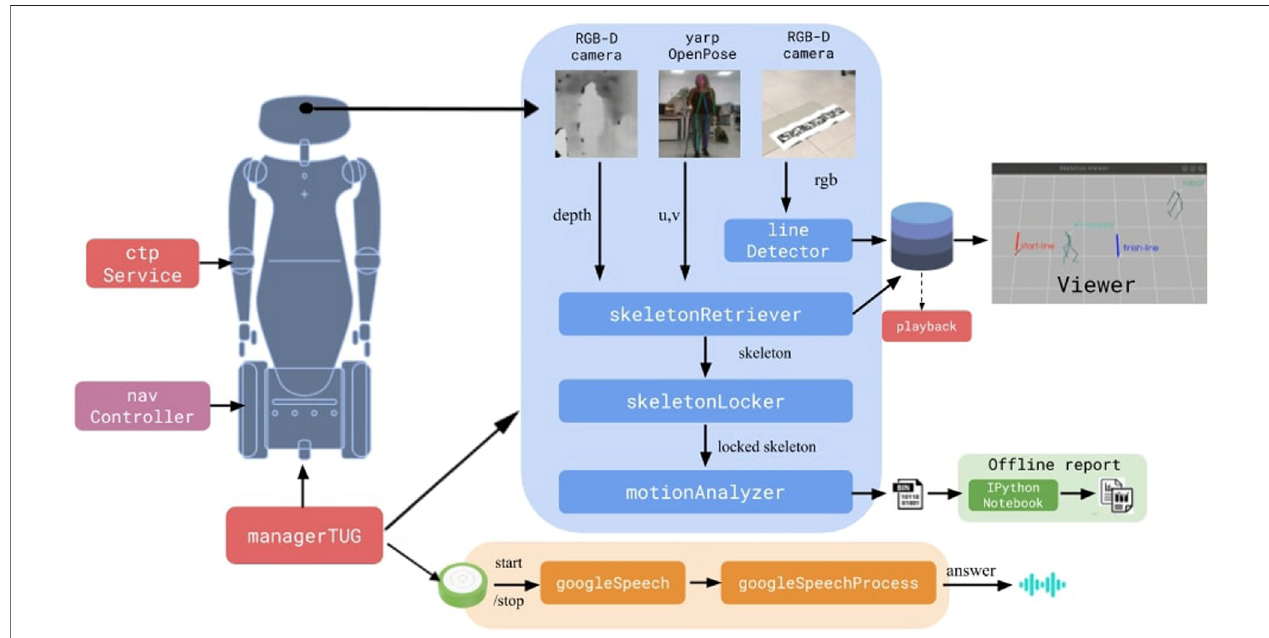
FIGURE 14 | The devised